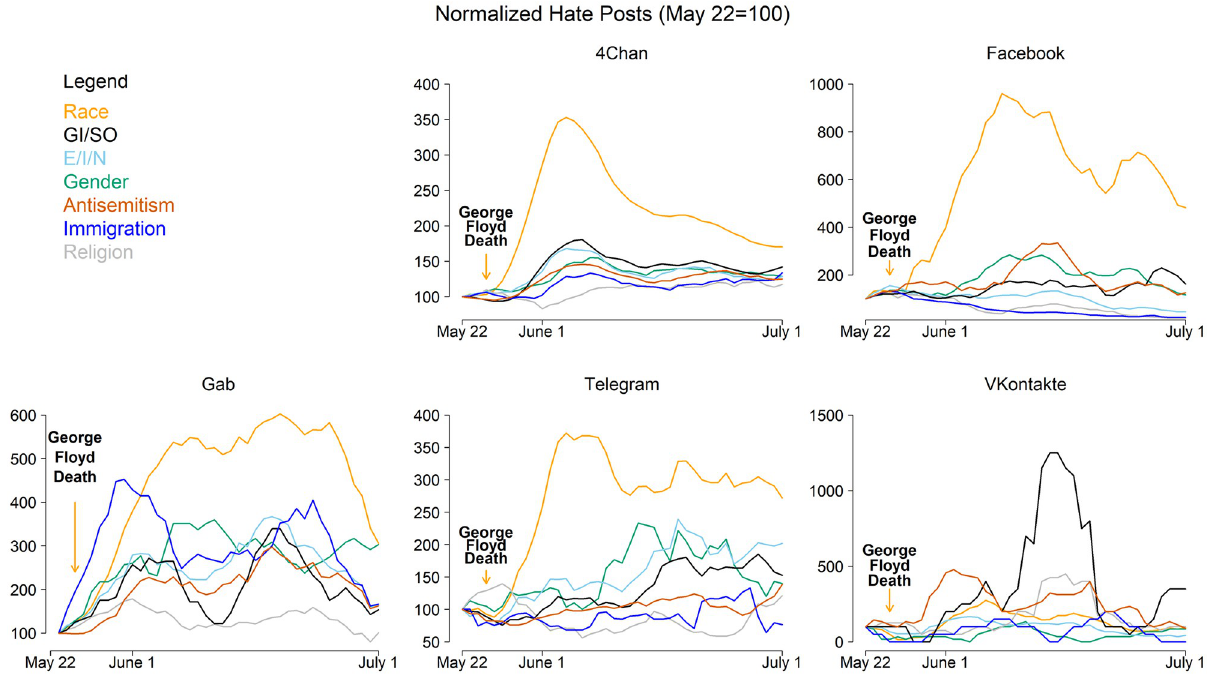
Fig 5. Hate speech by platform after George Floyd’s death. Each panel shows the changes in the levels of each type of hate speech following the death of George Floyd on a given